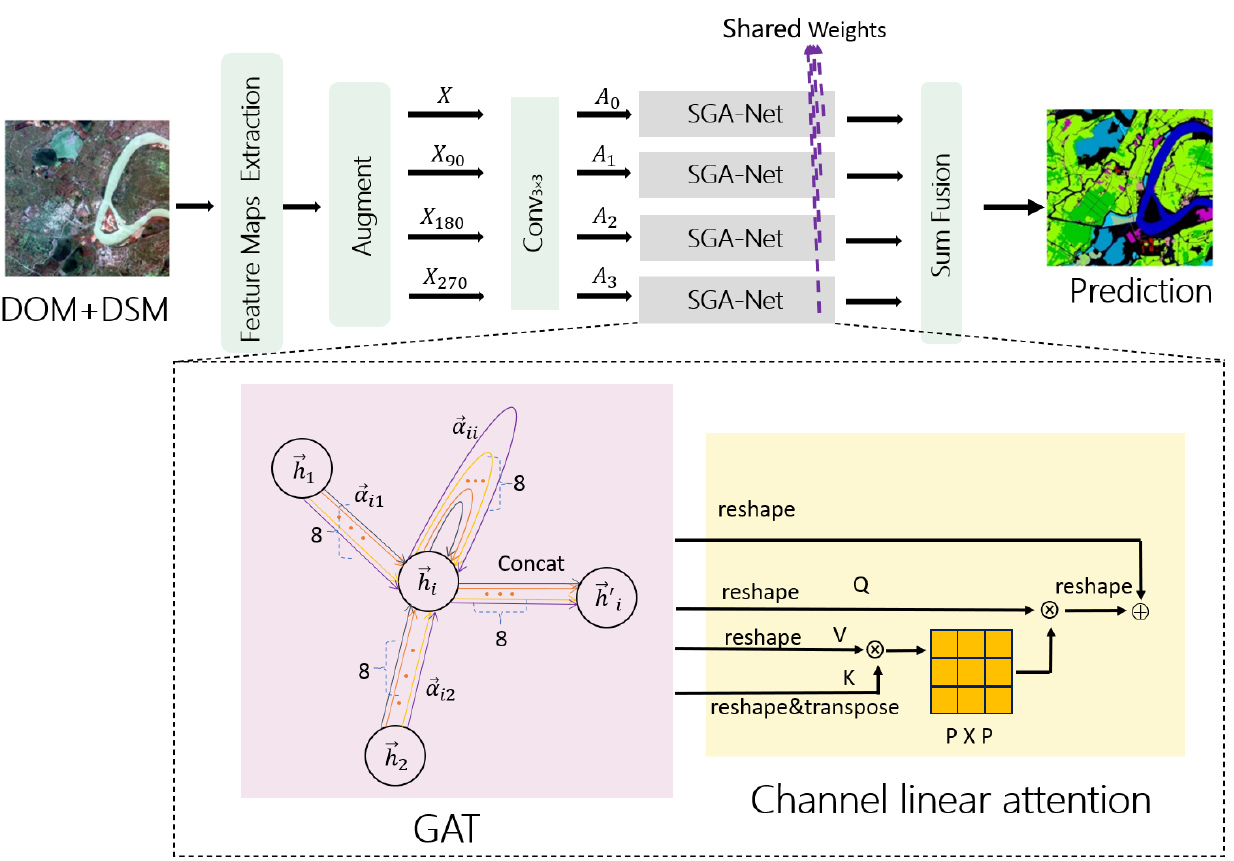
Figure 1. In the flow chart of our model for semantic segmentation, ResNet50 was selected as the feature maps extraction network of our model; Conv 3 × 3 means the convolution operation with kernel size 3; SGA-Net denotes the self-constructing graph attention network and channel linear attention mechanism; GAT is graph attention network, and Q , K , V of channel linear attention mechanism indicate query, key and value, respectively. X denotes the feature input, X 90 , X 180 and X 270 indicate the feature maps multi-views, where the index is the rotation degree, and A 0 , A 1 , A 2 and A 3 present the adjacency matrix of the self-constructing graph of corresponding feature maps. (cid:126) h i means initial feature vector of each node, where i ∈ [1, 3]; (cid:126) α represents the correlation coefficient; Concat denotes a concatenating operation; P indicates the number of channels, and (cid:126) h (cid:48) indicates the output of self-constructing graph attention neural i